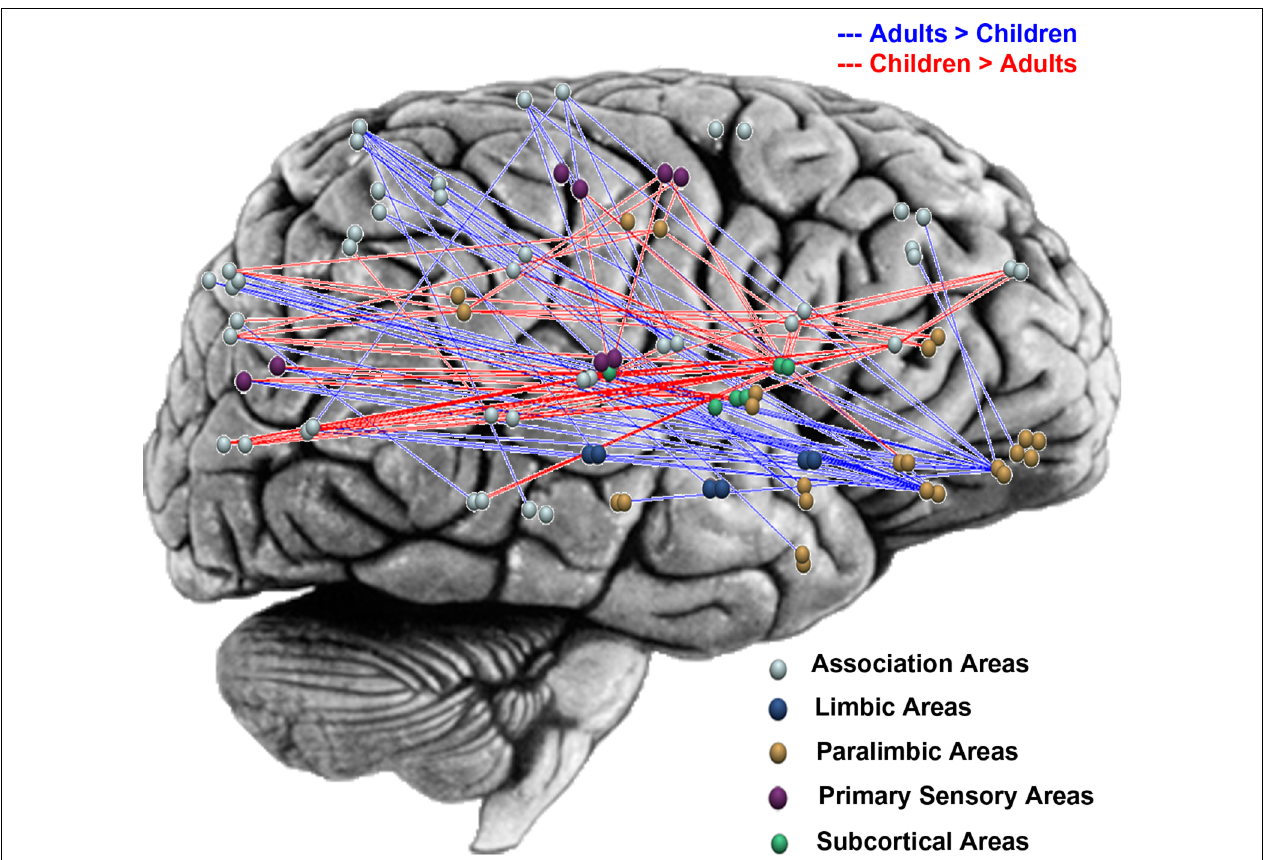
FIGURE 1 | Graphical representation of developmental changes in functional connectivity along the posterior–anterior and ventral–dorsal axes, highlighting higher subcortical connectivity (subcortical nodes are shown in green) and lower paralimbic connectivity (paralimbic nodes are shown in gold) in children, compared to young-adults. Brain regions are plotted using the y and z coordinates of their centroids (in millimeter) in the MNI